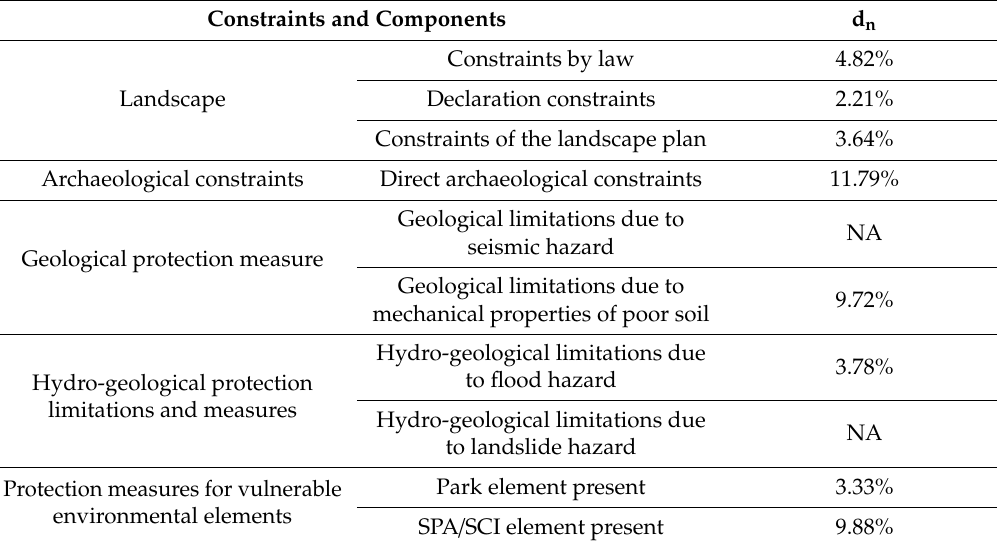
Table 4. Application